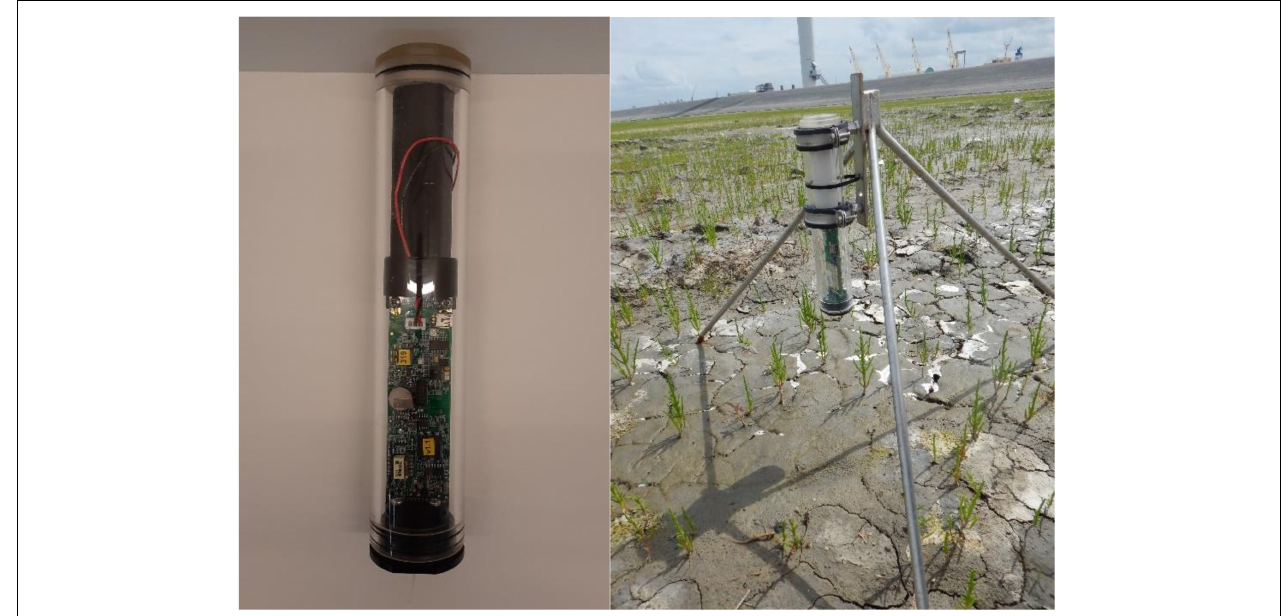
FIGURE 2 | The A-SED sensor (left) and the A-SED sensor deployed in the field (right) .